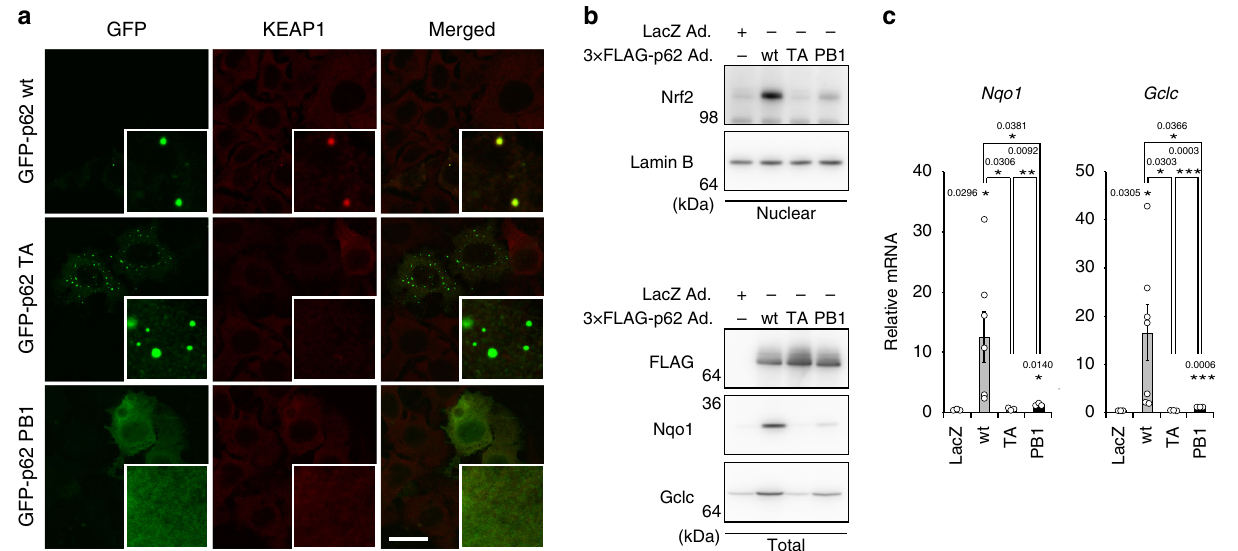
Fig. 7 Signi fi cance of Keap1 on p62-gels. a p62 -de fi cient Huh-1 cells were transfected with wild-type p62, T350A or PB1 mutant. 24 h after the transfection, the cells were immunostained with Keap1 antibodies. Bar: 20 μ m. b Wild-type p62, T350A or PB1 mutant was expressed in primary mouse hepatocytes using adenovirus system. 48 h after the infection, the cells were fractionated into cytosolic and nuclear fractions, which were subjected to immunoblot analysis with the indicated antibodies. Data shown are representative of three separate experiments. Source data are provided as a Source Data fi le. ( c ) Gene expression of Nrf2-targets. Total RNAs were prepared from primary mouse hepatocytes expressing LacZ ( n = 7), wild-type p62 ( n = 7), T350A (n = 7), or PB1 mutant ( n = 3). Values were normalized against the amount of mRNA in LacZ-expressing hepatocytes. RT-qPCR analyses were performed as technical replicate on each biological sample. Data are means ± s.e. * p < 0.05, ** p < 0.01, and *** p < 0.001 as determined by two-sided Welch ’ s t -test. Source data are provided as a Source Data fi